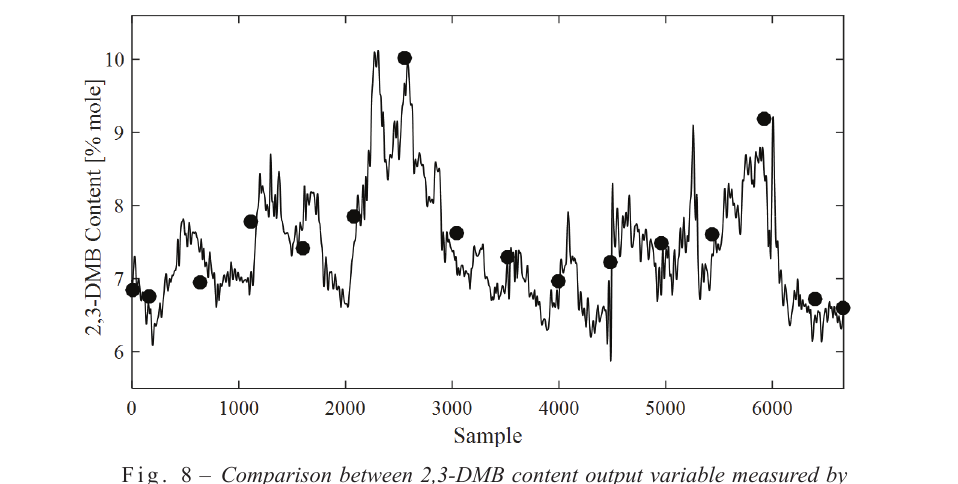
Fig. 8 – Comparison between 2,3-DMB content output variable measured by the on-line chromatographic analyser and the laboratory analysis within 2015 data period